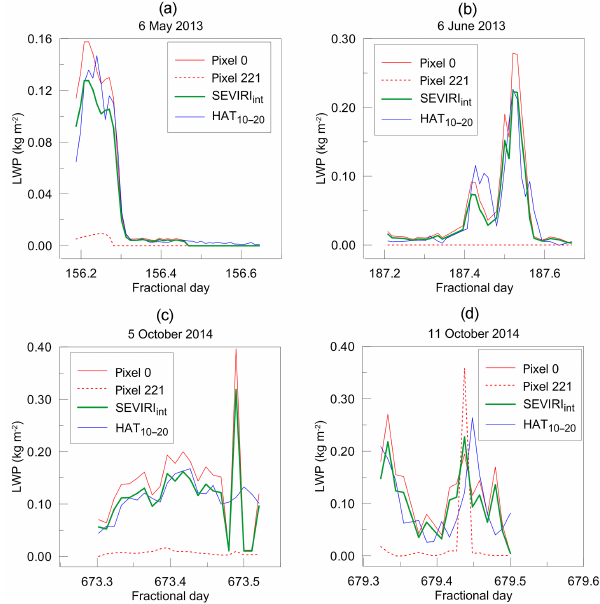
Figure 8. The examples of instantaneous measurements of LWP by SEVIRI (pixel 0, pixel 221 and the interpolated value) and by HATPRO (HAT 10 − 20 data set used). Several days of the WH season are shown (1 day is one